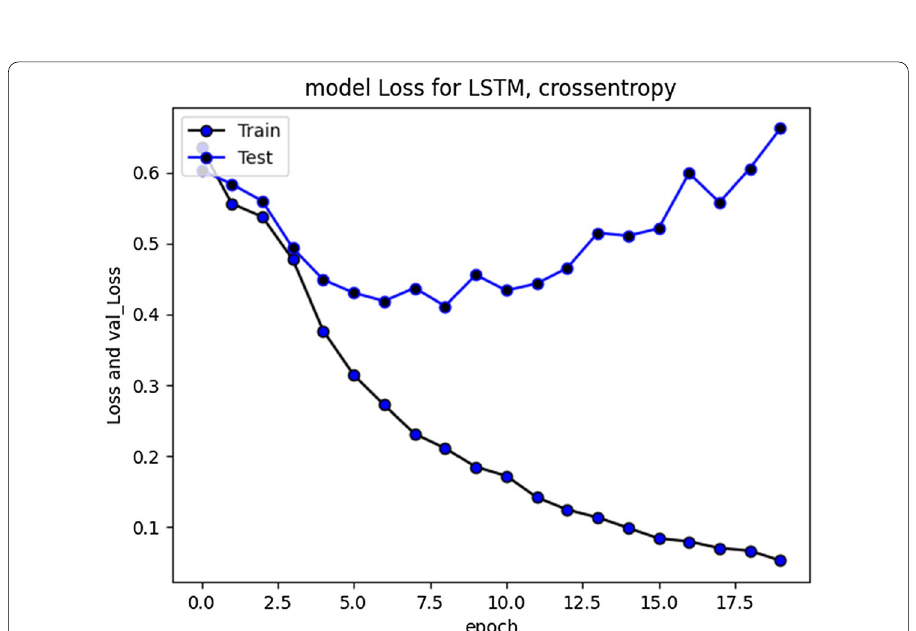
Fig. 7 RNN-LSTM Model loss plot- Binary Cross entropy for 20